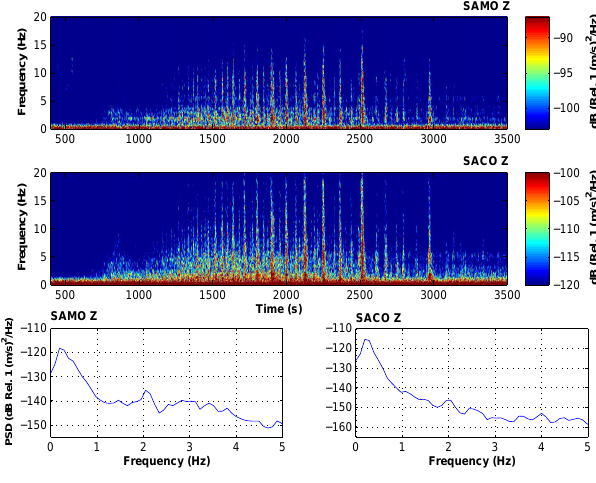
Fig. 14. Spectrogram (top) of 1h windows of vertical component of SAMO and SACO seismic stations of ground velocity of the seismic swarm recorded on 13 December 2011 between 18:40 and 20:00UTC, and a detailed view between 0 and 5Hz of the power spectra (bottom) of 10min time window before the swarm, which display a peak around 2Hz. The spectrograms were computed with the same method as Fig.